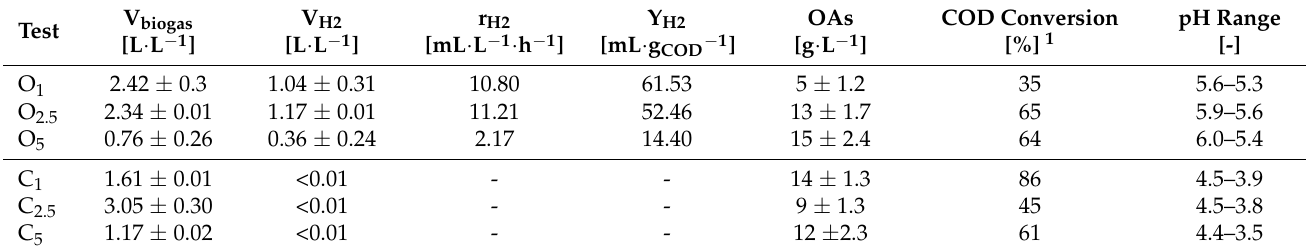
Table 3. Results of SET OMW and SET CW